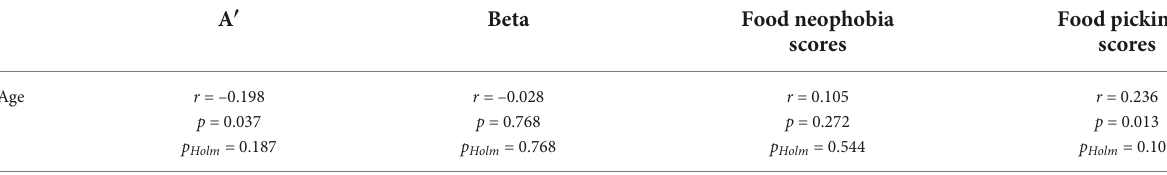
TABLE 4 Pairwise Pearson correlation coefficients between children’s age and their A (cid:48) , Beta, food neophobia, and pickiness scores.